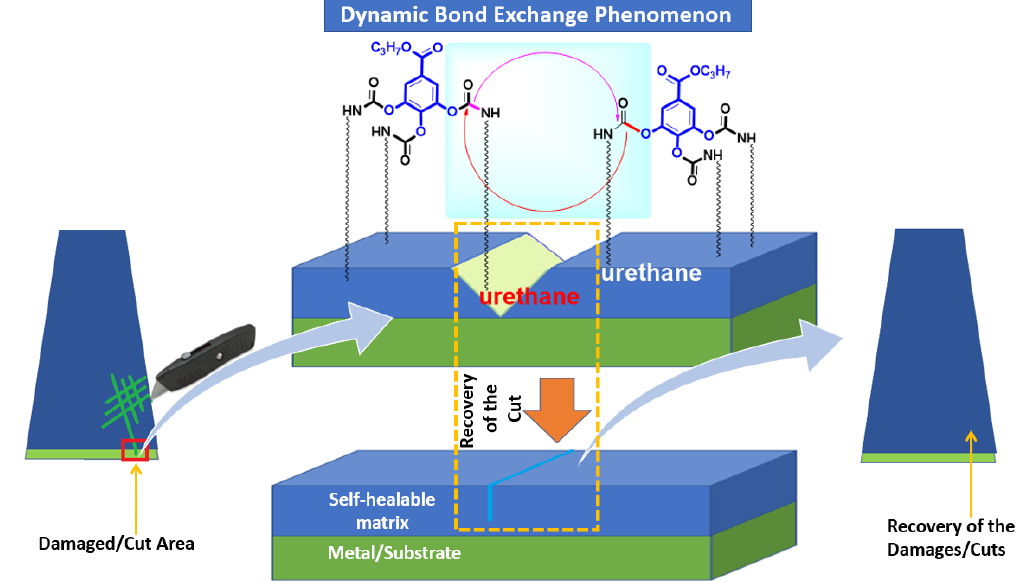
Figure 5. Dynamic bond exchange in self-healing polyurethane network [64].